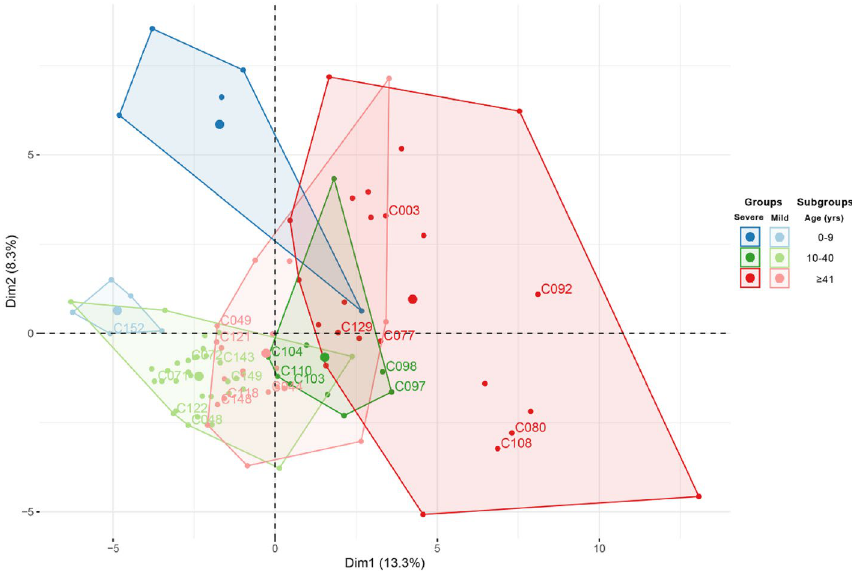
Figure 1. Exploratory multivariate analysis. Factor analysis of mixed data (FAMD) with grouping variables identified four dissimilar groups: the two main groups (Severe and Mild), and the two age-related subgroups (10–40 years old; 41–85 years